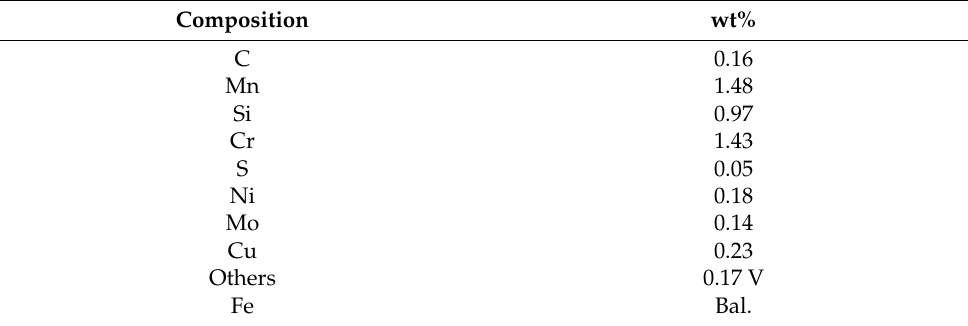
Table 1. Chemical composition of the steel used in this study (wt.%).